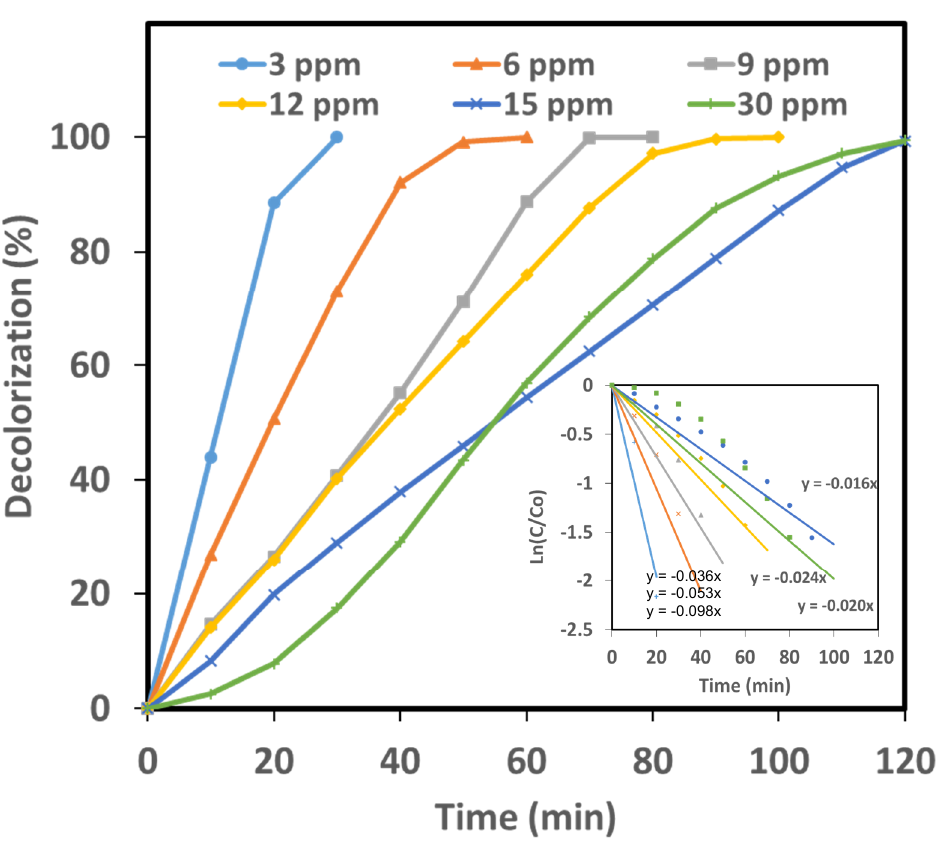
Figure 6. Effects of MB concentration on decolorization efficiency. Na 2 SO 4 electrolyte: 0.05 mol L − 1 ; reaction time: 2 h; electrode distance: 3 cm; initial pH: 6.0; reaction temperature: 25 °C; MB: 3~30 mg L − 1 ; cell voltage: 20 V.